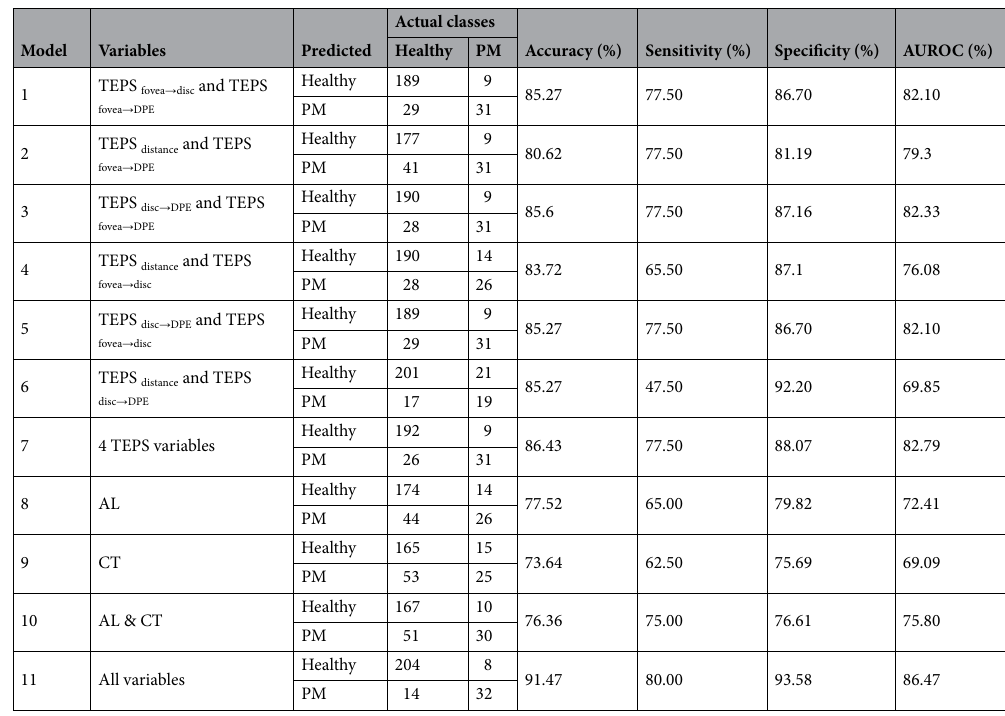
Table 3. Confusion matrix (actual versus predicted classes), accuracy, sensitivity, specificity, AUROC of the support vector machine classification on each of 11 models. AL axial length, AUROC area under receiver operating characteristic curve, CT choroidal thickness, DPE deepest point of the eyeball, PM pathologic myopia, TEPS tomographic elevation of the posterior